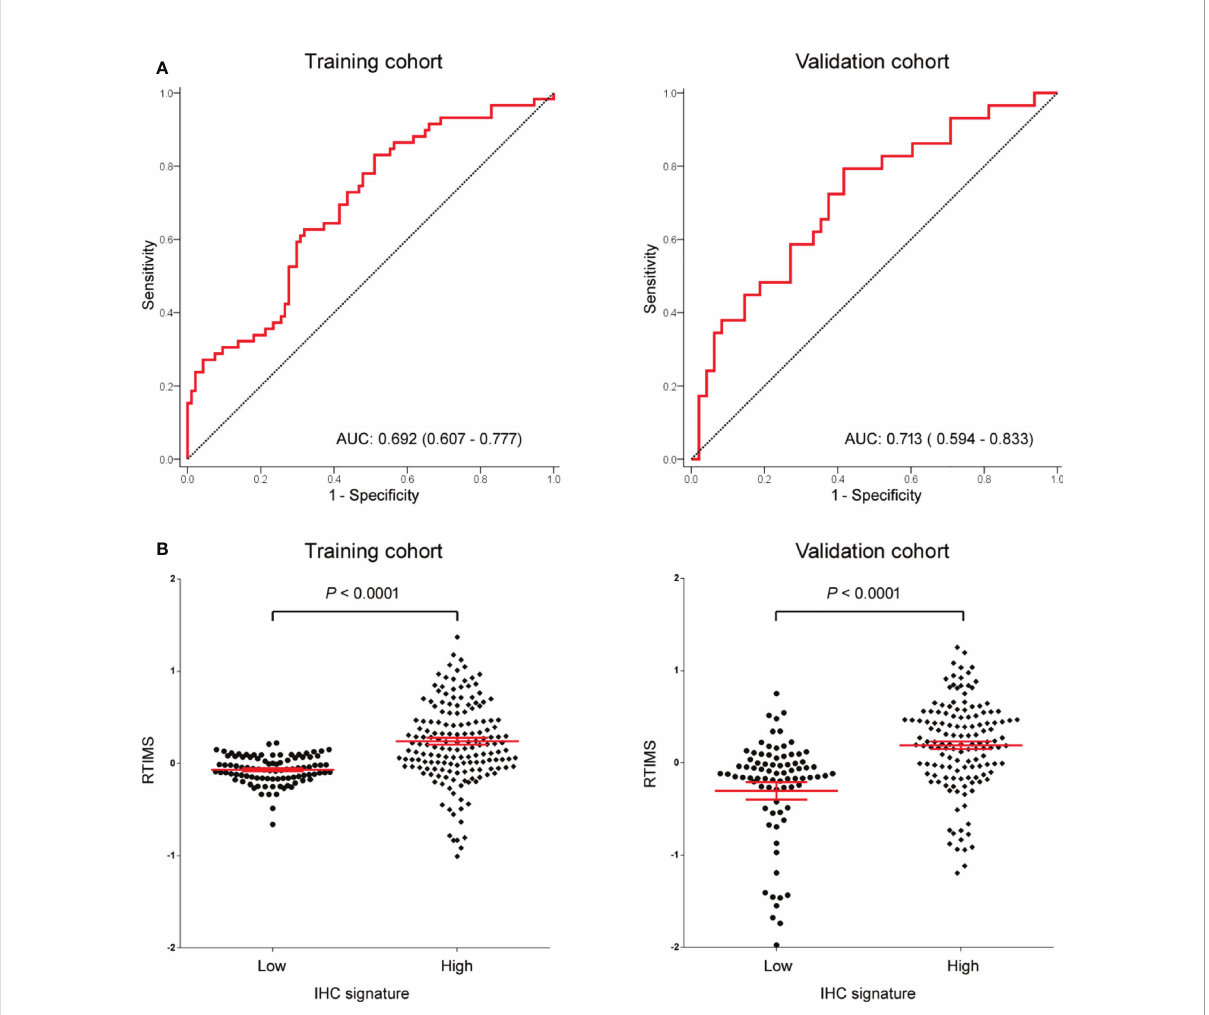
FIGURE 2 (A) AUC of the receiver operator characteristic of RTIMS predicting the tumor immune microenvironment signature in the training cohort and validation cohort. (B) RTIMS by high and low IHC signature. RTIMS, radiomics tumor immune microenvironment score. AUC, area under the